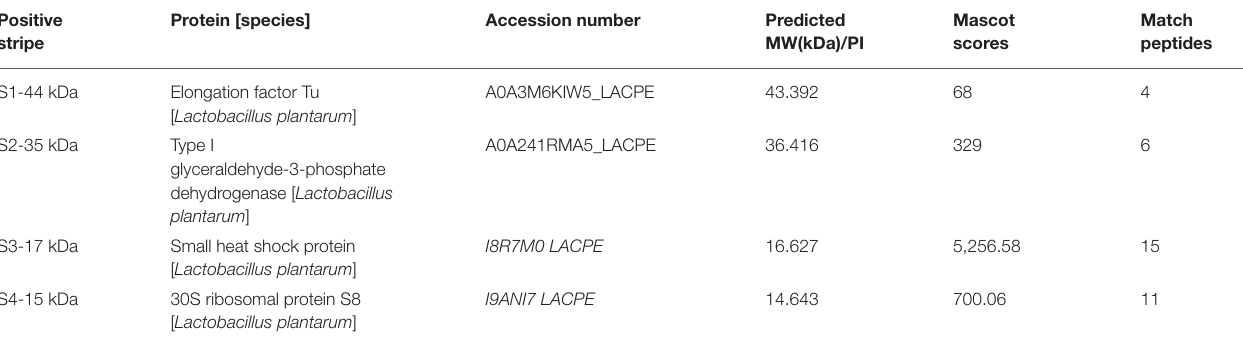
TABLE 1 | Mass spectrometric identification of HC-2 surface adhesion proteins interacts with the epithelial cells and crude intestinal mucus of shrimp. Positive